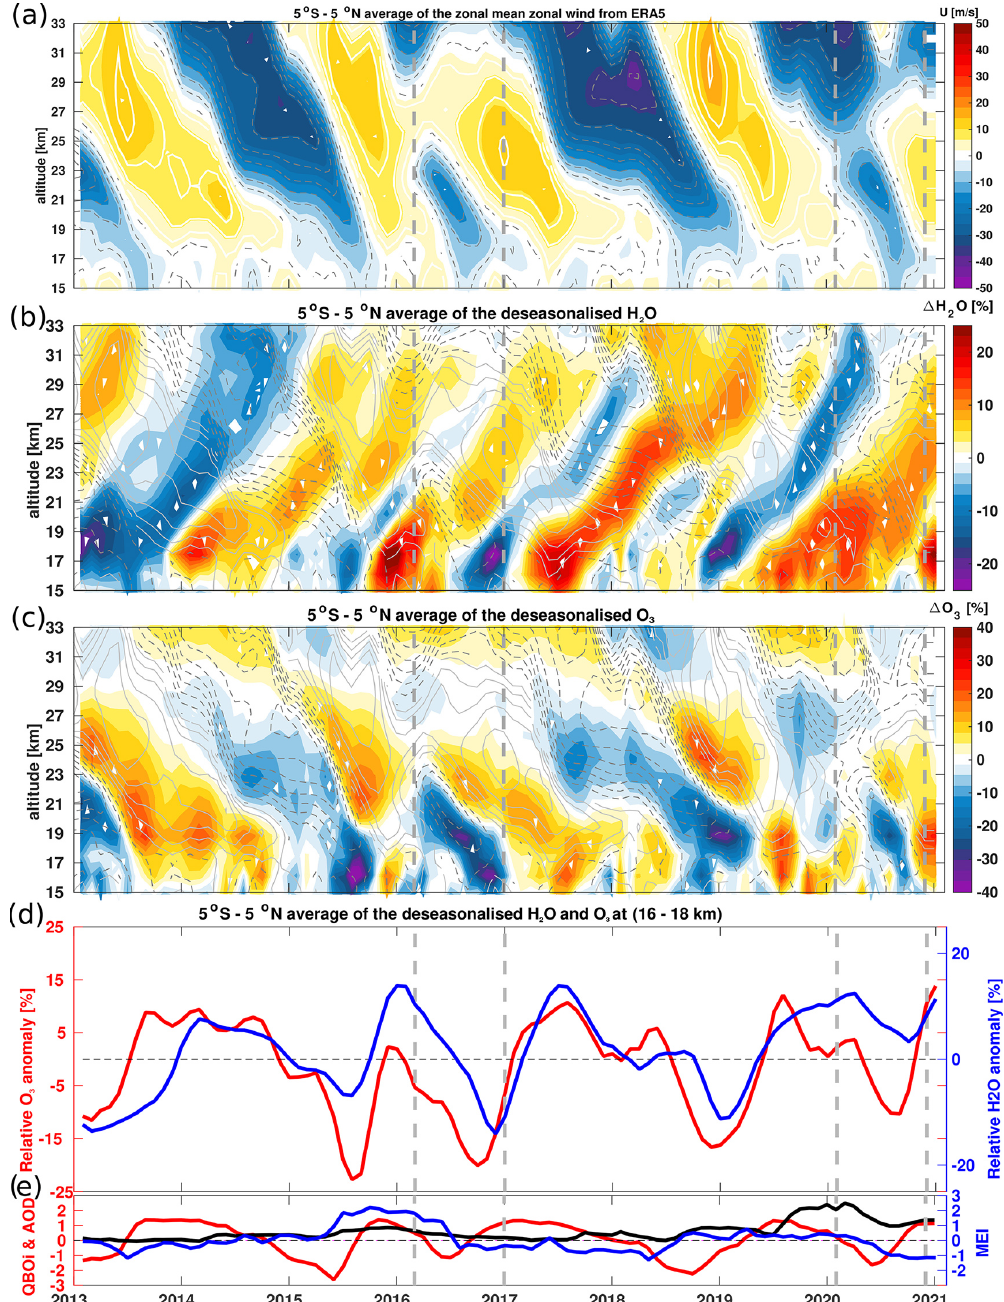
Figure 1. Tropical average of the zonal mean zonal wind ( U ) from the ERA5 reanalysis and deseasonalized stratospheric H 2 O and O 3 time series from MLS satellite observations for the 2013–2020 period in percent change from long-term monthly means as a function of time and altitude. Shown are (a) zonal mean zonal wind U , (b) deseasonalized monthly mean H 2 O anomalies, and (c) deseasonalized monthly mean O 3 anomalies. (d) Tropical average of the deseasonalized lower-stratospheric H 2 O (blue) and O 3 (red) time series between the altitudes of 16 and 18km. The lowermost panel (e) shows the QBO index at 50hPa (21km) in red, the MEI in blue, and the AOD index in black. The vertical grey dashed lines indicate February 2016 and January 2020 for the QBO disruption onset and December 2016 and November 2020 for the QBO disruption offset. The monthly averaged zonal mean zonal wind component, U (ms − 1 ), from the ERA5 reanalysis is overlaid as solid white (westerly wind) and dashed grey (easterly wind) contour